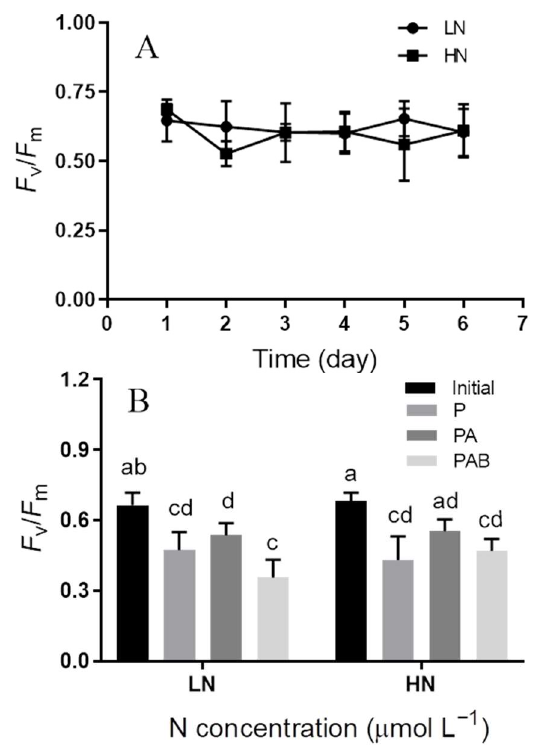
Figure 2. F v / F m of Sargassum horneri in the 6-day pre-cultivation period ( A ) and after 2 h of exposure to P, PA, and PAB ( B ). Significant differences among all treatments are indicated by different lowercase letters ( p < 0.05).